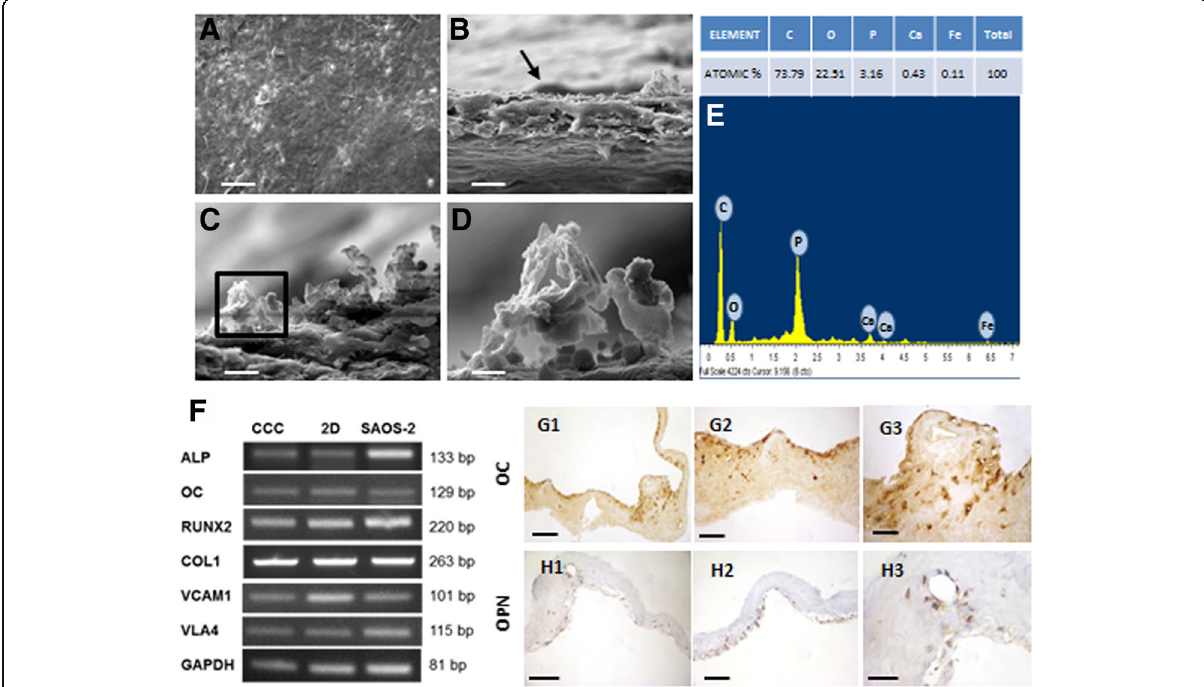
Fig. 5 Osteogenic differentiation on Collagen I-based Cell Carrier (CCC). a , b SEM images of differentiated DPPSC adhered on CCC surface ( black arrow). c SEM image of differentiated DPPSC with hydroxyapatite deposition on CCC surface. d SEM image of hydroxyapatite deposition on CCC. Scale bars: 100 μ m ( a ), 20 μ m ( b ), 10 μ m ( c ), 2 μ m ( d ). e Microanalysis of the CCC surface with atomic concentrations. f RT-PCR gene expression analysis of differentiation markers (OC, ALP, COL1) and adhesion markers (VCAM1, VLA4) in DPPSC cultured on CCC, DPPSC cultured on 2D (plastic surface) and SAOS-2 cultured on CCC. GAPDH was used as a housekeeping. g , h Immunohistochemistry of differentiation markers (OC, OPN) in differentiated DPPSC on CCC. Scale bars: 1000 μ m ( g1 , h1 ), 400 μ m ( g2 , h2 ); 200 μ m ( g3 , h3